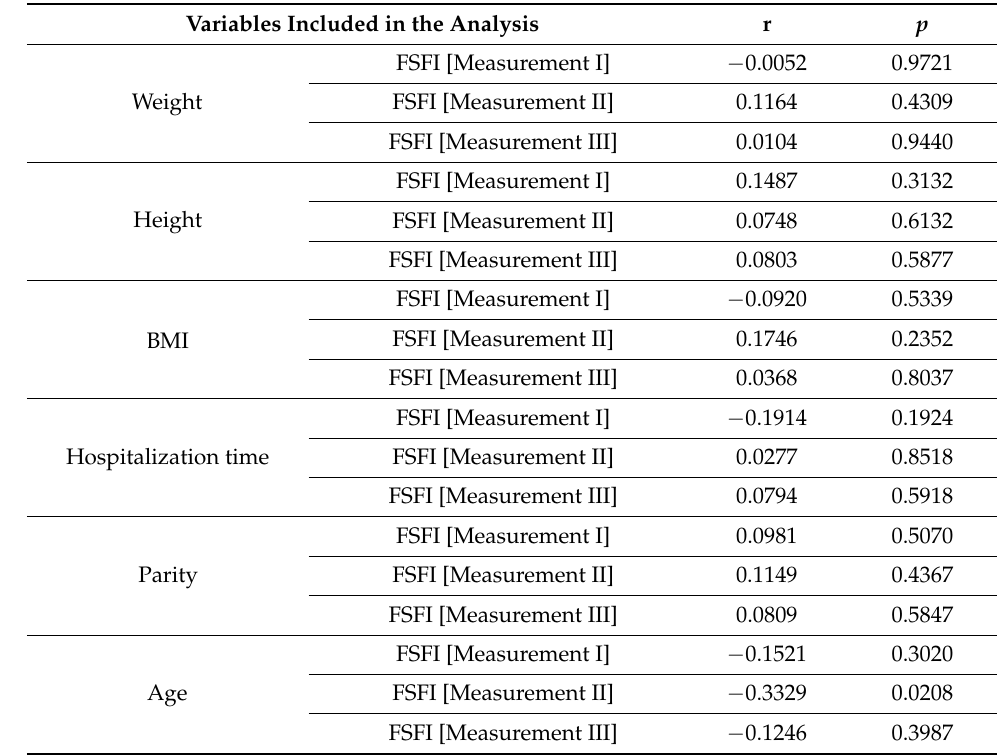
Table 5. Correlation between FSFI scores and quantitative clinical and demographic stales.